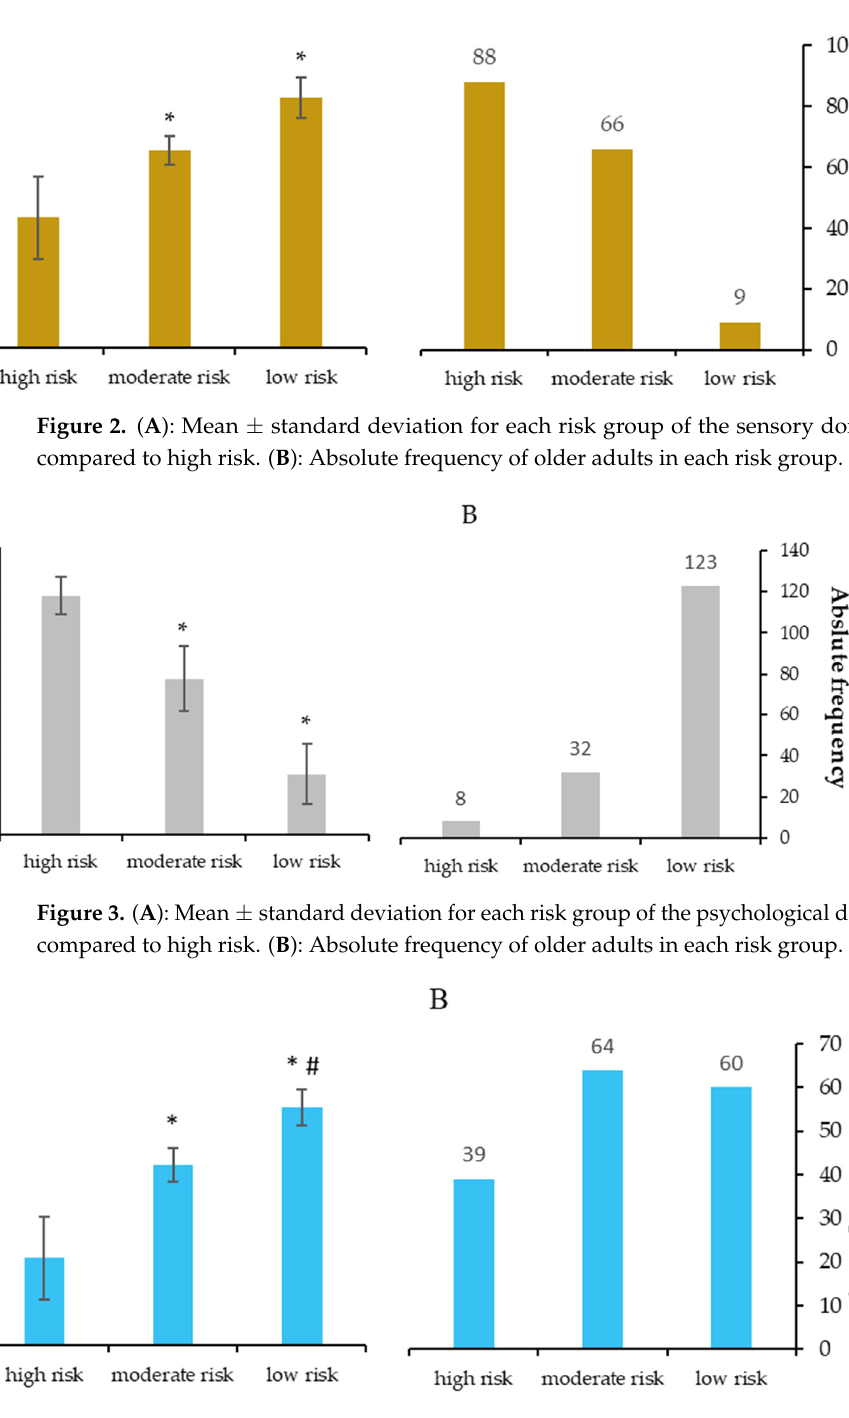
Figure 4. ( A ): Mean ± standard deviation for each risk group of the locomotion domain. * p < 0.001 compared to high risk; #: p = 0.002 compared to moderate risk. ( B ): Absolute frequency of older adults in each risk group.